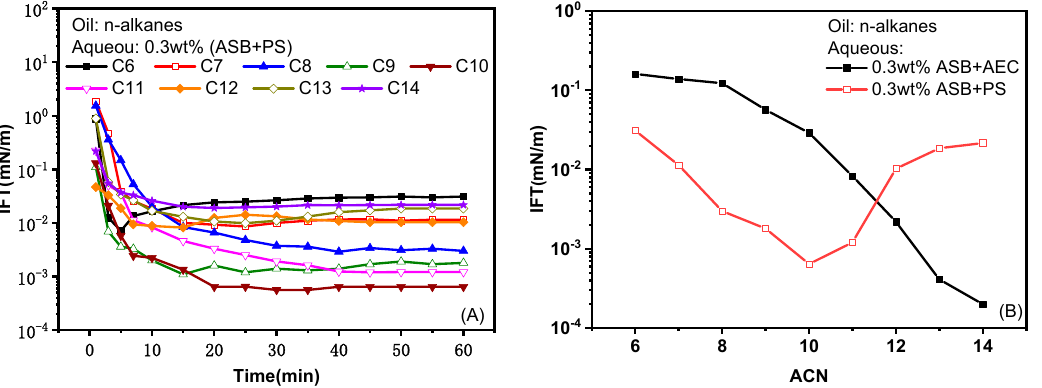
Figure 2. Dynamic IFTs of 0.3 wt% ASB@PS solution ( A ) and equilibrium IFTs of 0.3 wt% ASB@AEC and ASB@PS solutions ( B ) against n-alkanes.